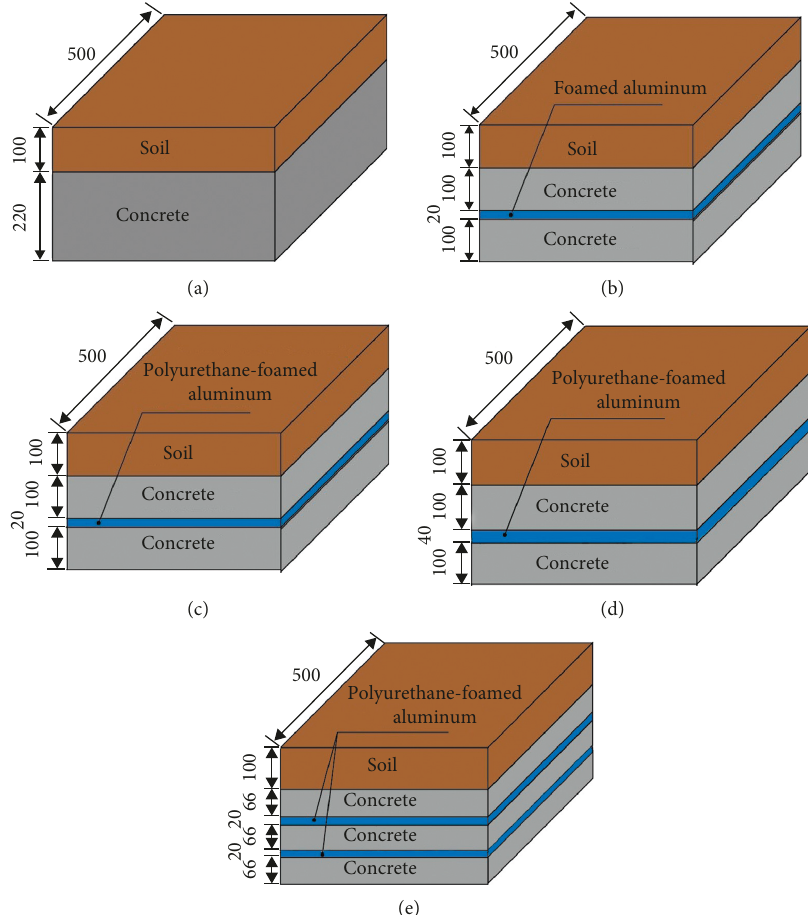
Figure 4: Different test combinations. (a) Test 1. (b) Test 2. (c) Test 3. (d) Test 4. (e) Test 5.